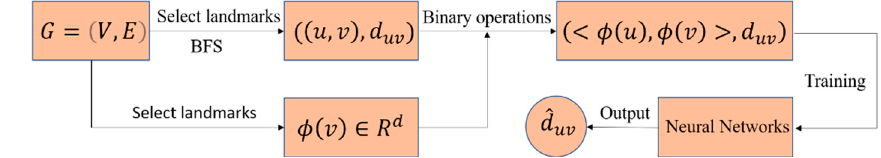
Figure 2. Base architecture of